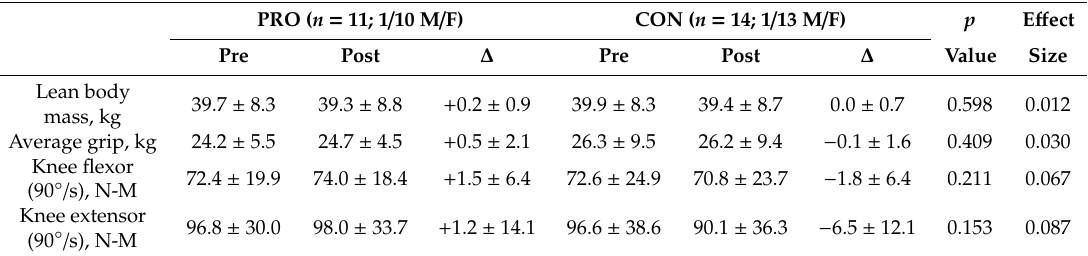
Table 2. Change in lean body mass and strength in PRO and CON participants